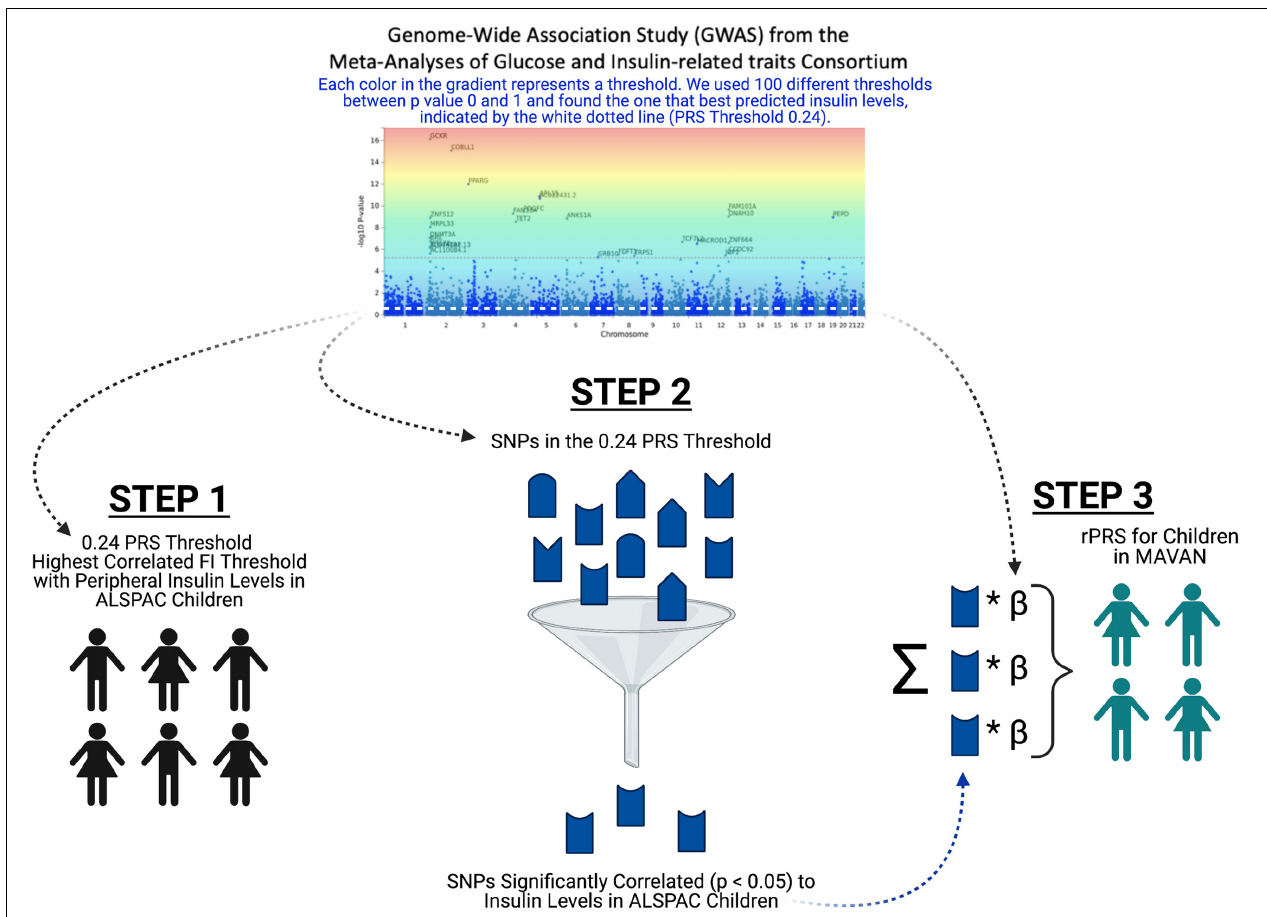
FIGURE 5 | Refined PRS (rPRS) methodology. This flow chart depicts the rPRS process. Each color in the gradient on the fasting insulin GWAS represents a threshold. In step 1, we used 100 different thresholds between p -value 0 and 1 from the fasting insulin GWAS and found the threshold that best predicts insulin levels in ALSPAC Children (PRS threshold 0.24), indicated by the white dotted line on the GWAS. In step 2, we ran a correlation for each SNP within the 0.24 PRS threshold to find which SNPs significantly predicted ( p < 0.05) the peripheral insulin levels. Lastly, in step 3, using the SNPs that significantly predicted peripheral insulin levels from step 2, we calculated the rPRS in the MAVAN